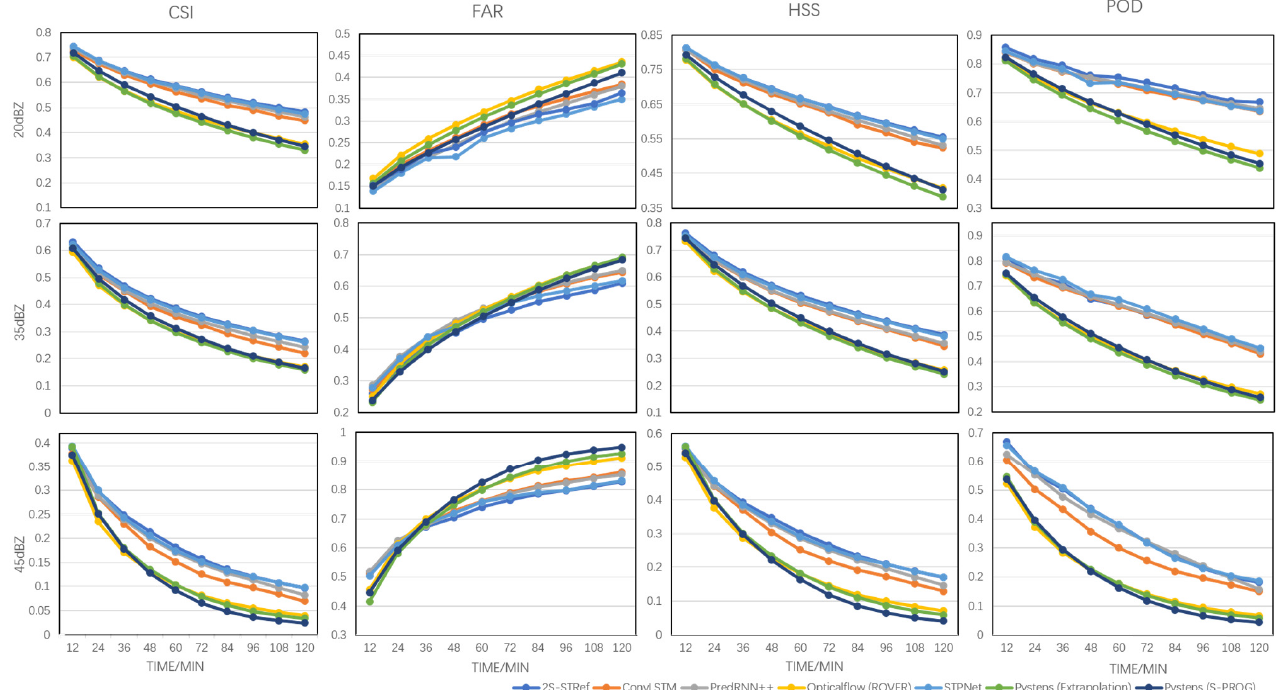
Figure 10. Nowcasting metric scores (CSI, HSS, FAR, POD at different thresholds) for 12- to 120-min lead times. The increasing rate curves comparing the proposed 2S-STRef with PredRNN++ and accuracy improvement compared with PredRNN++, especially for the important CSI and HSS metrics. Moreover, the second-stage network RefNet can further enhance the forecasting accuracy for the 12- to 120-min lead